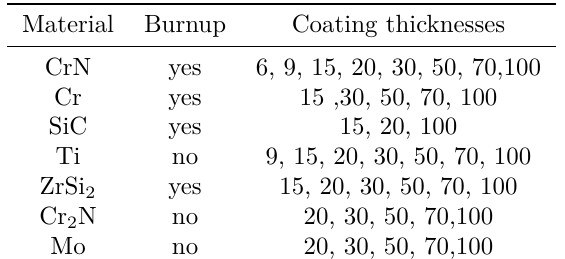
clearly to absorption neutron cross section. The